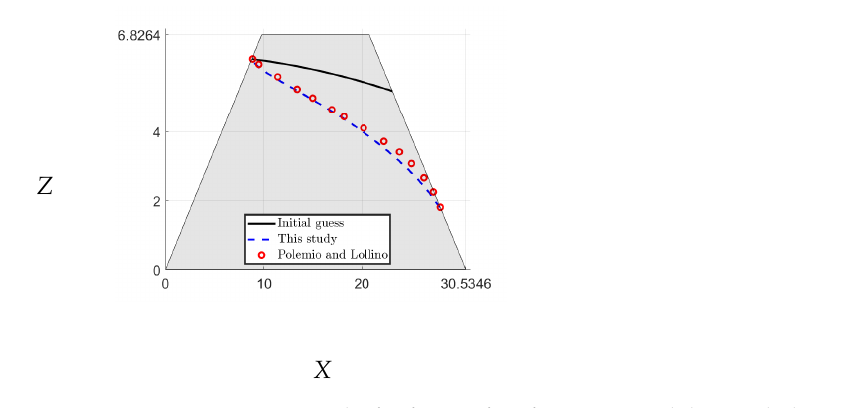
Figure A4. Comparing our results for free surface for a trapezoid dam with the numerical solution of [11].